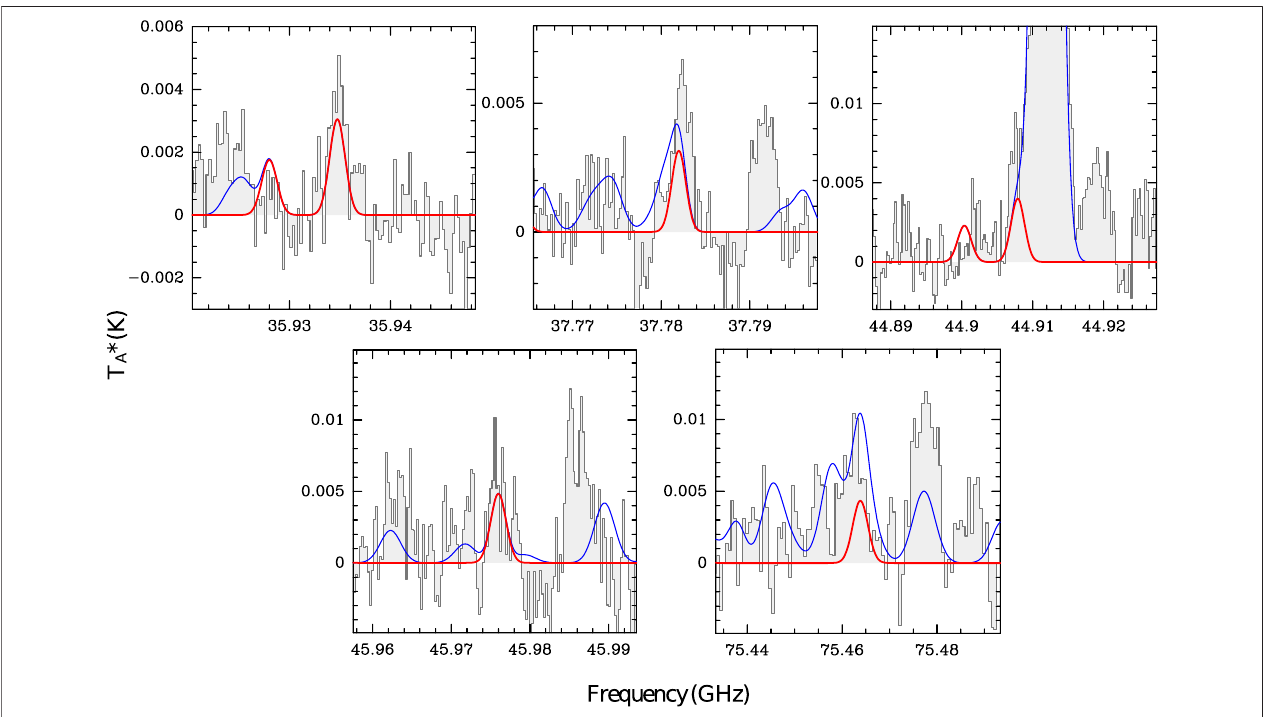
FIGURE4| Selectedtransitionsofglycolonitrile(HOCH 2 CN;see Table2 )detectedtowardstheG+0.693molecularcloud.ThebestLTE fi tderivedwithMADCUBA for the HOCH 2 CN emission is shown with a red curve, while the blue curve shows the total emission considering all the species identi fi ed towards this molecular cloud. The y-axis shows the line intensity in antenna temperature scale ( T A * ) in Kelvin, and the x-axis shows the frequency in GHz.